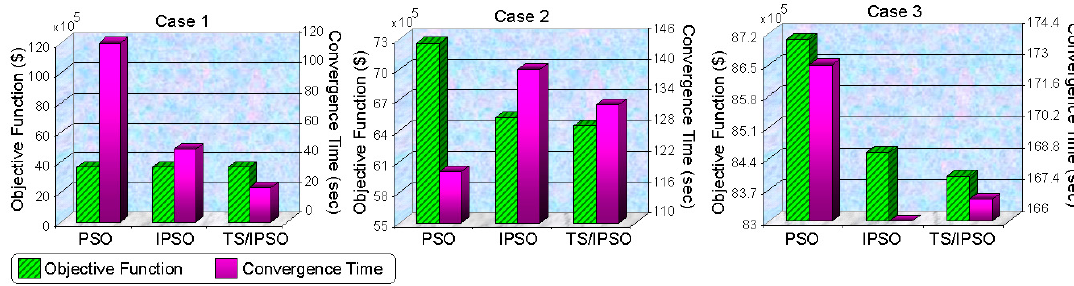
Figure 6. Comparison of conventional PSO, Improved PSO (IPSO) and hybrid Tabu Search / Improved